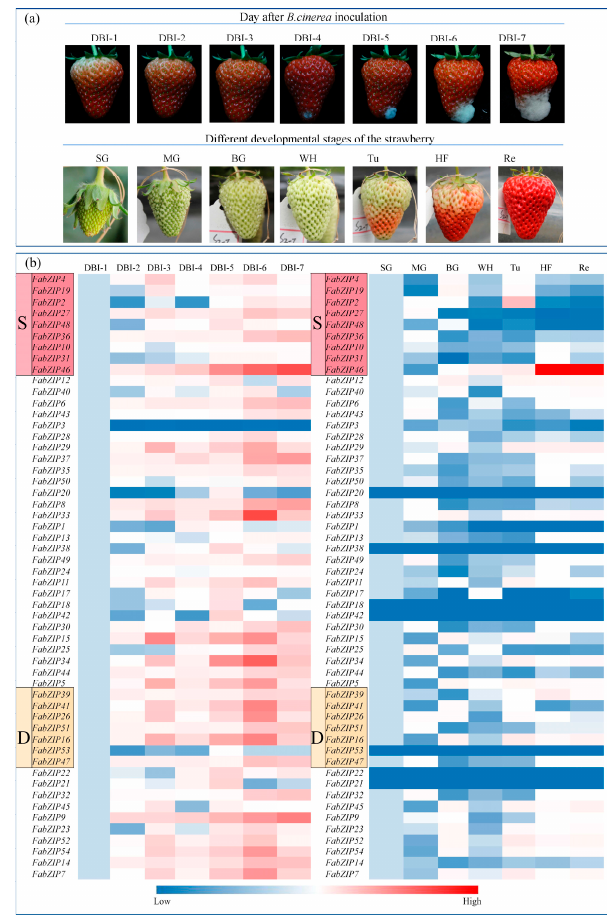
Figure 5. ( a ) Photographs showing the different developmental stages of strawberries. The whole process of strawberry development was divided into SG, MG, BG, Wh, Tu, HF, and Re stages. Phenotypes of red fruit after Botrytis cinerea inoculation. ( b ) The expression of FabZIP genes in different strawberry growth stages and in different stages after Botrytis cinerea inoculation of red